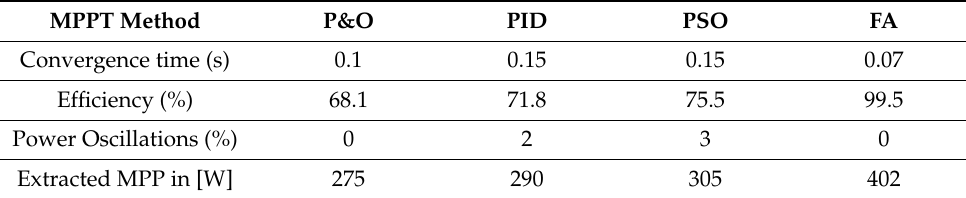
Table 7. Performance comparison of FA, P&O, PID and PSO (Case 3).